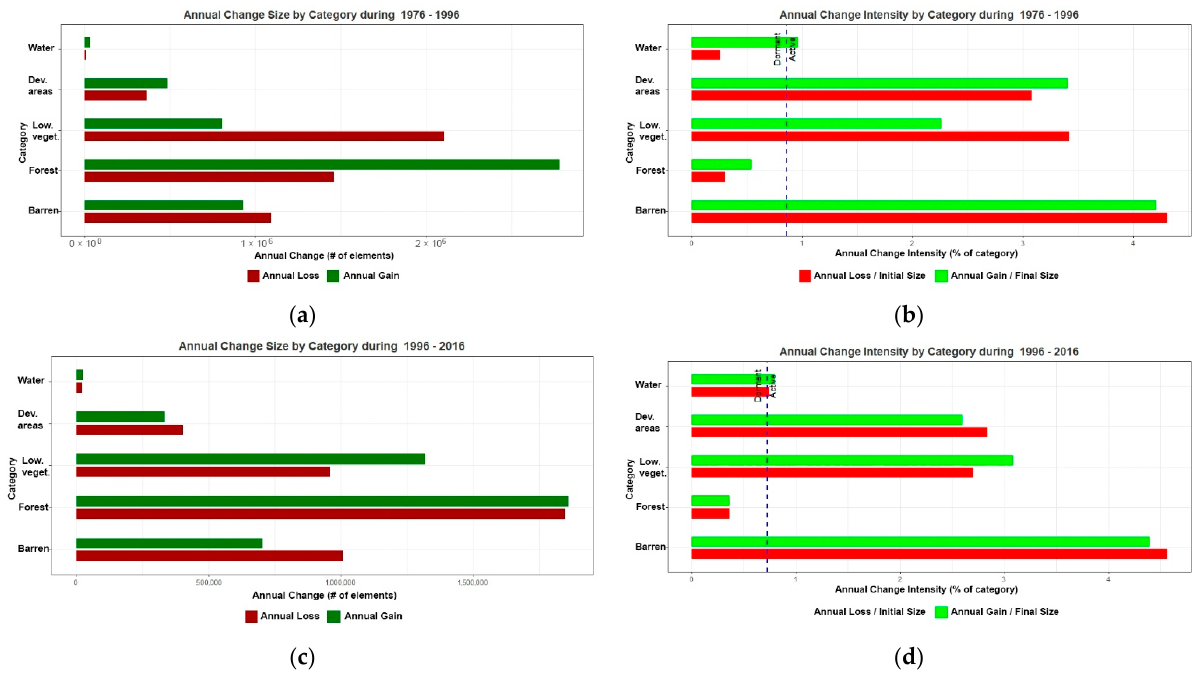
Figure 10. Plots at the category level for the two intervals; ( a ) annual change size by category during 1976–1996; ( b ) annual change intensity by category during 1976–1996; ( c ) annual change size by category during 1996–2016; ( d ) annual change intensity by category during 1996–2016.